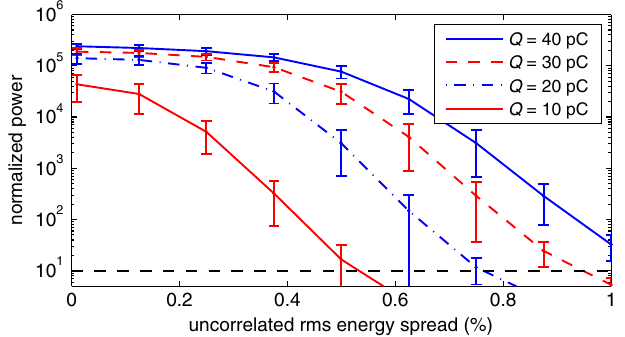
FIG. 1. Total emitted power (log scale) normalized to the spontaneous radiation level, scanning bunch charge, and rms energy spread in a range of Q ¼ 10 – 40 pC , corresponding to FIG. 2. Scan of the undulator parameter K by changing the beam currents I ¼ 2 : 4 – 9 : 6 kA , Pierce parameters (cid:4) ¼ (cid:2) 0 – 1 : 0% , respectively. Data are obtained undulator gap size, for an electron bunch of Q ¼ 40 pC and 1 : 4 – 2 : 3% , and ^ (cid:1) (cid:2) different uncorrelated energy spreads. Error bars mark 1 standard from time-dependent GENESIS simulations, with each data point deviation of the fluctuation in power originating from runs with averaged over 10 runs with different shot-noise seeds, and error different shot-noise seeds, with each data point averaged over 10 bars marking the standard deviation of the fluctuation in shot-to- runs. Large undulator parameters are required to permit FEL shot power. The black dashed line indicates an amplification by gain for beams of broad spectral width. This dependency weak- ¼ 0 : 25% if the FEL is ens as indicated by the flat curve for ^ (cid:1) (cid:2) no longer dominated by the energy